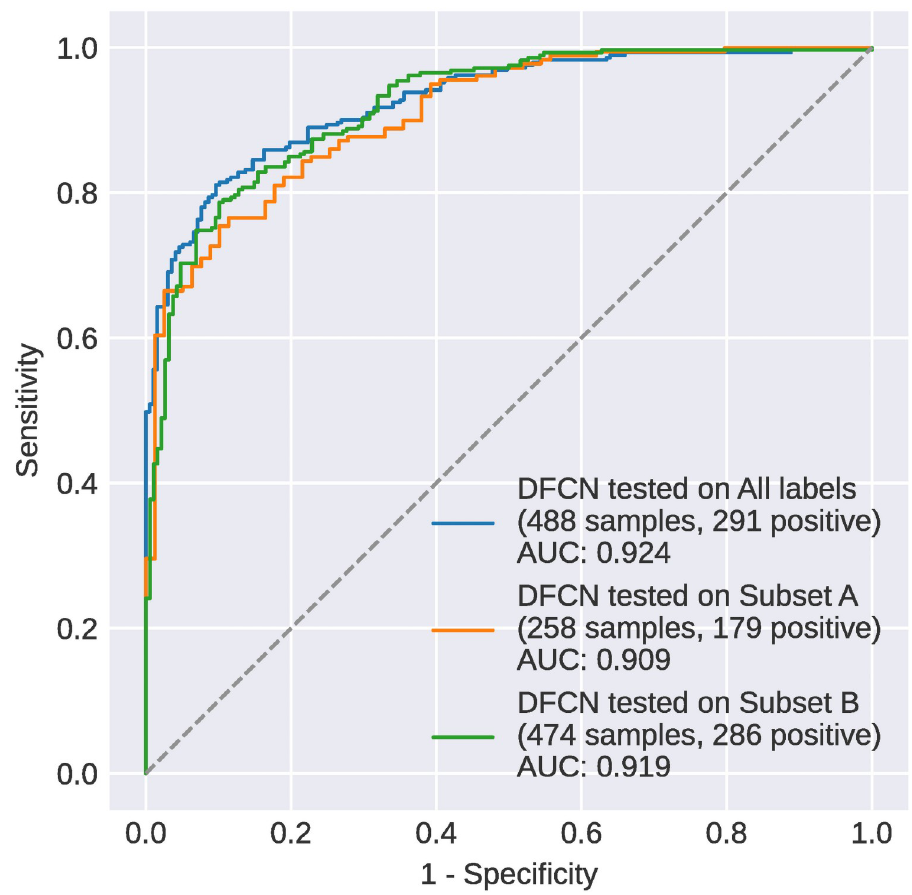
Fig 7. Comparison of the ROC curves of DFCN for all available inputs, for the subset A and the subset B.